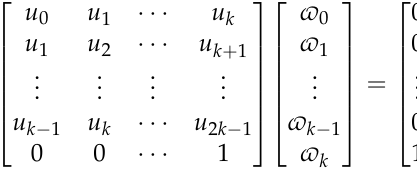
Figure 2. Framework of the SSR-ETM and ETM.